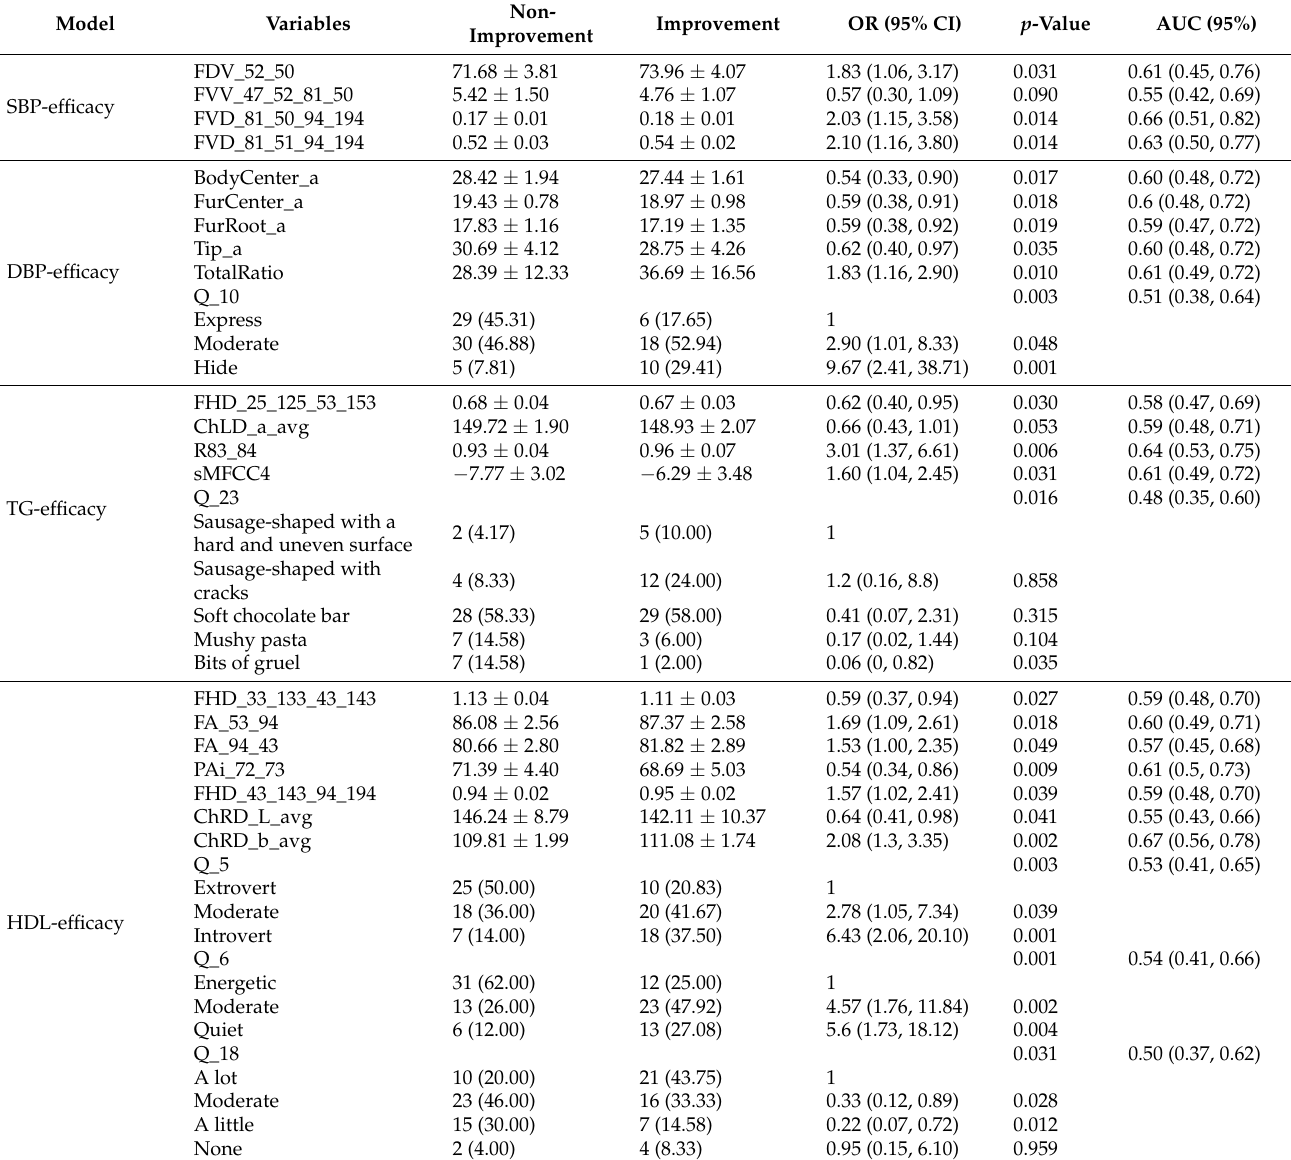
Table 3. Analysis of variables in each model selection by the least absolute shrinkage and selection operator (LASSO). Model